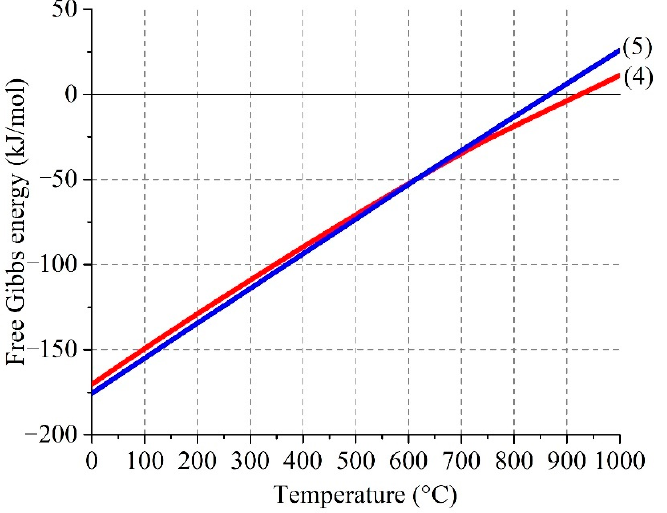
Figure 5. Effect of temperature on Gibbs free energy of the interactions of sulfur trioxide with zinc (4) and copper (5) ferrites.